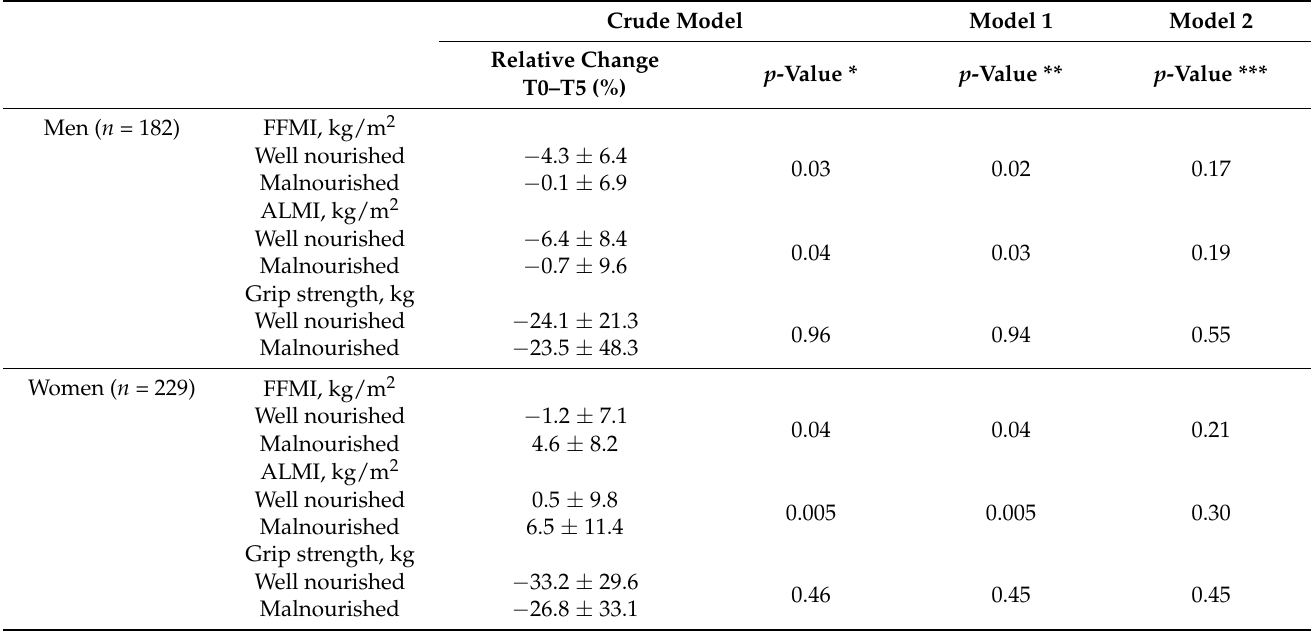
Table 3. Relative change over time of muscle mass and muscle strength over a five-year period according to nutritional status and gender ( n = 411).